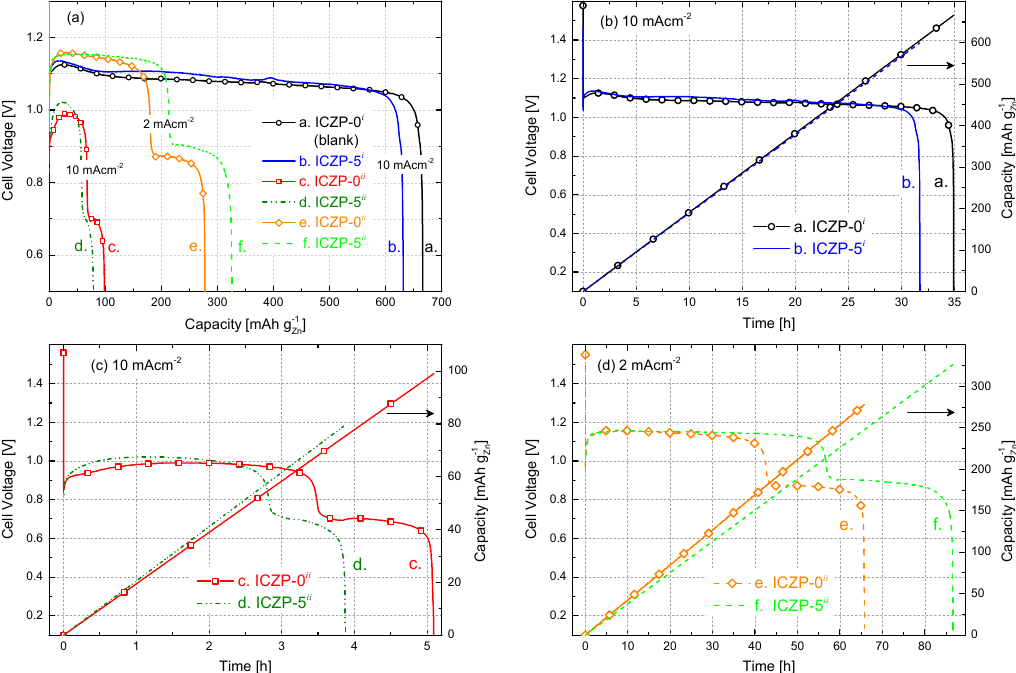
Figure 6. ( a ) Depth of discharge profiles of zinc–air cells based on uncoated (ICZP-0) and 5 wt. % ionomer-coated (ICZP-5) Zn particles in 6.6 M KOH ( i : blank) and modified ( ii : 4s-2) aqueous alkaline electrolytes at different current densities and ( b – d ) a comparison of the discharge capabilities for each cell as a function of the time.